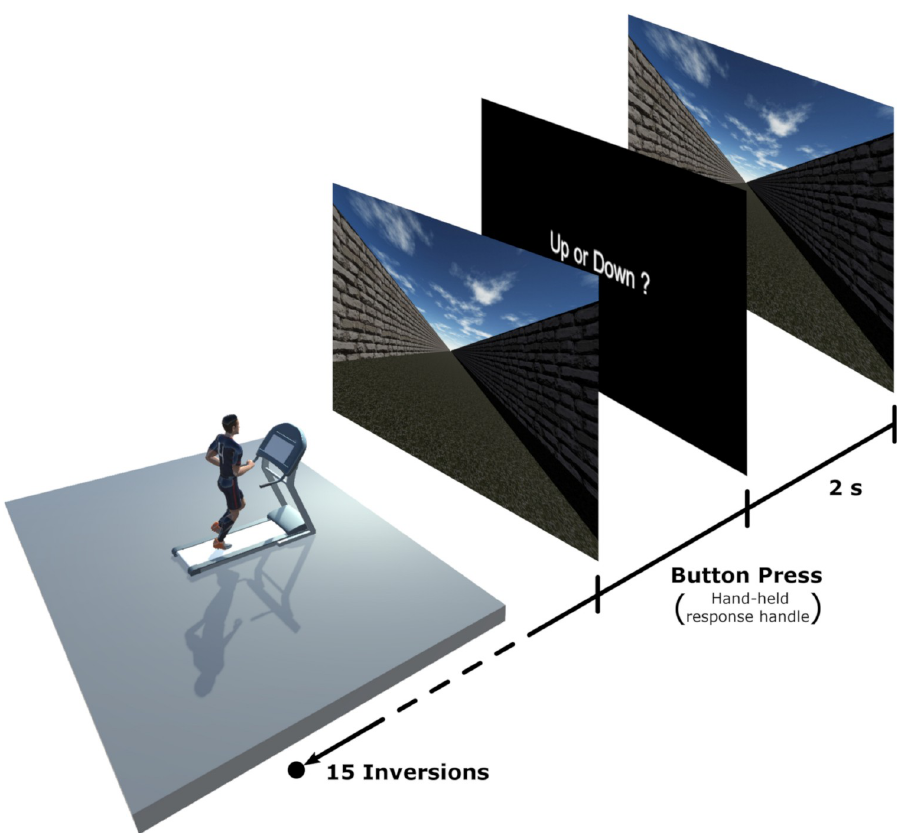
Fig 1. Schematic representation of the experimental set-up. Participants were running on the treadmill in front of a large projection screen (4.30x2.70m). For each trial, a moving visual scene representing an open-air hallway was briefly presented and participants were asked to indicate whether the scene was moving faster or slower than their actual running